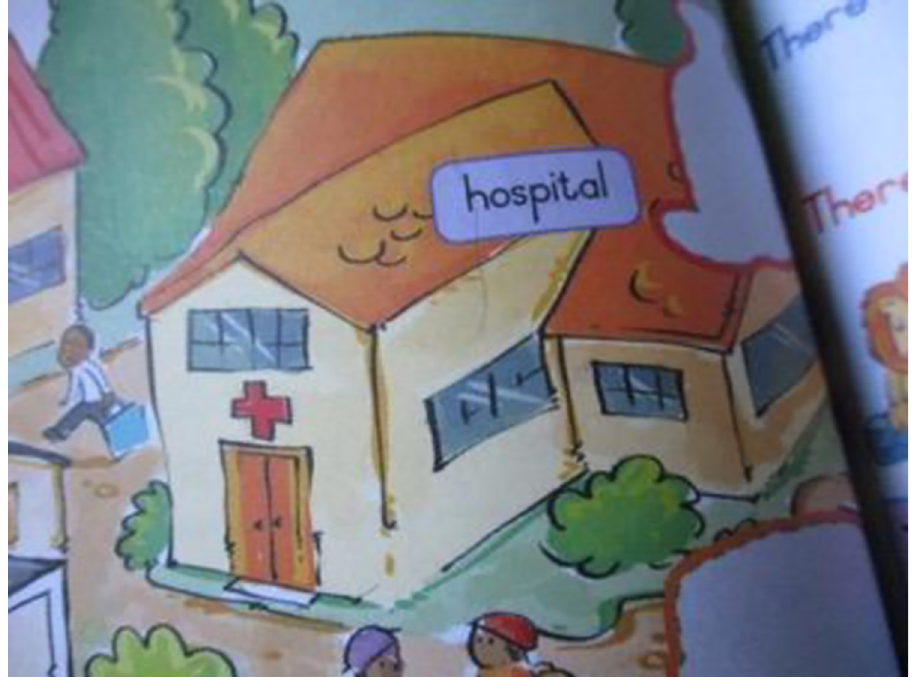
Fig 2. Image from co researcher